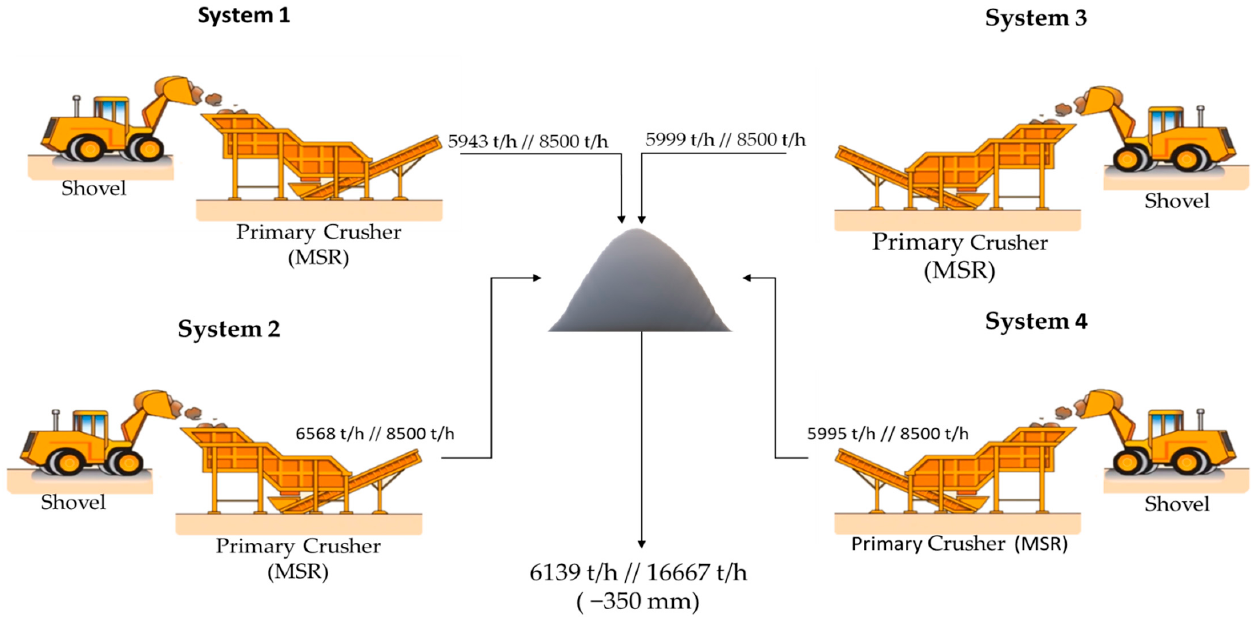
Figure 1. Flowchart of loading and primary crushing operations in a truckless mine. The ore deposit is composed of a lateritic cover (canga) over a main body of friable hematite with jaspillite lenses, as shown in Figure